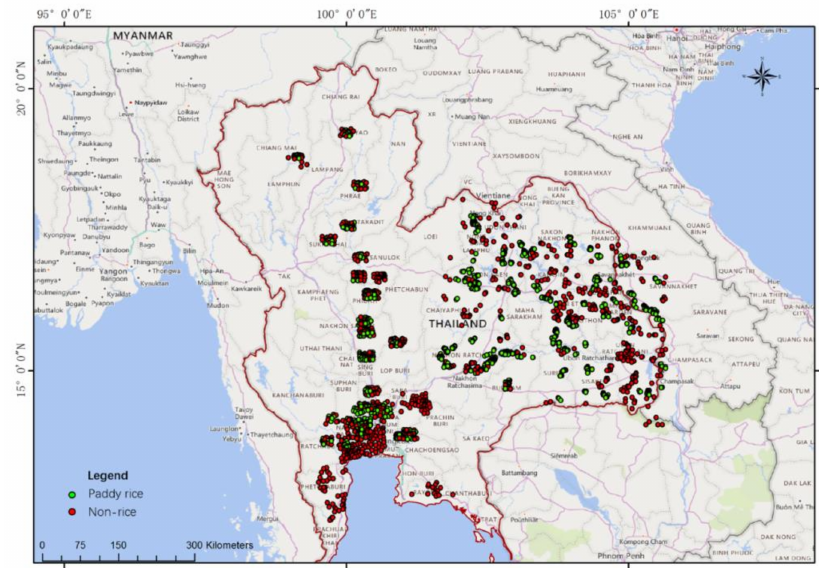
Figure 15. Distribution of the validation samples.